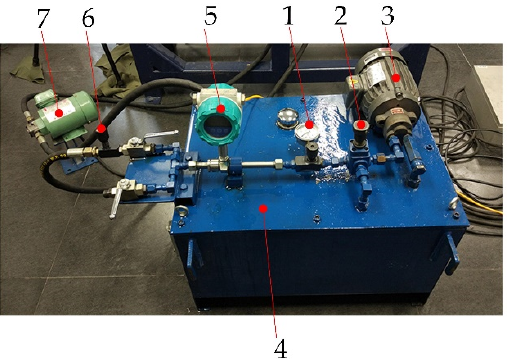
Figure 22. Design of hydraulic system (1 = pressure gauge; 2 = relief valve; 3 = gear pump; 4 = oil tank; 5 = flow meter; 6 = speed control valve; 7 =